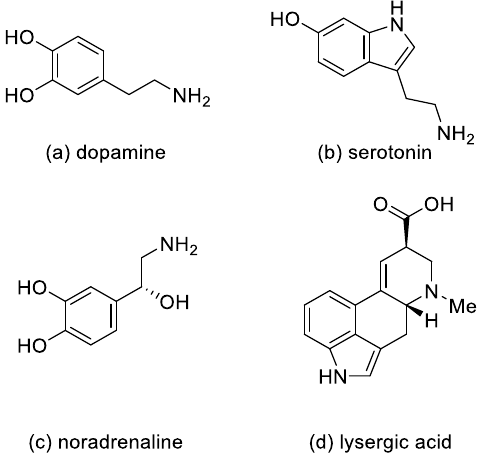
Figure 3. Structural formulas of endogenous amines and lysergic acid.